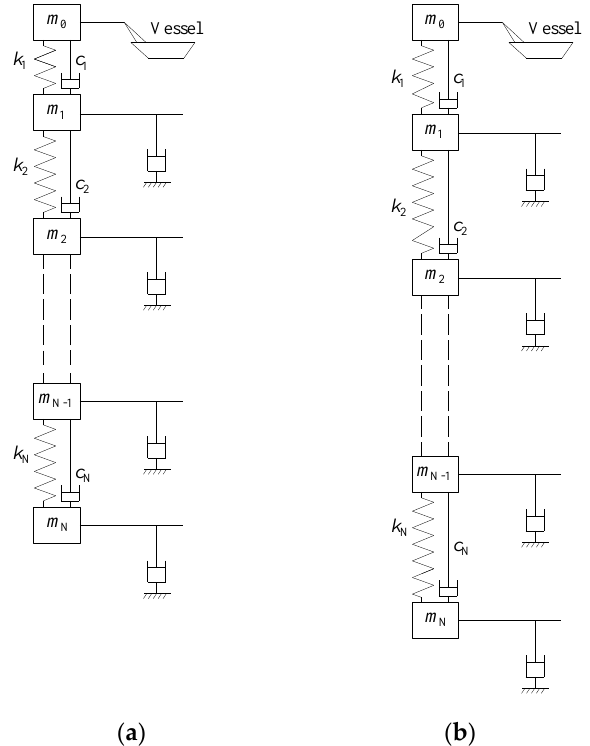
Figure 3. Schematic diagram of the variant-domain method. ( a ) Initial configuration of the discrete system; ( b ) adjusted configuration of the discrete system with segment length increased.